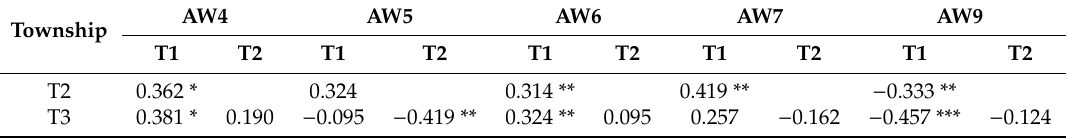
Table 9. Comparison of awareness scores among three townships by Schi ff ’s